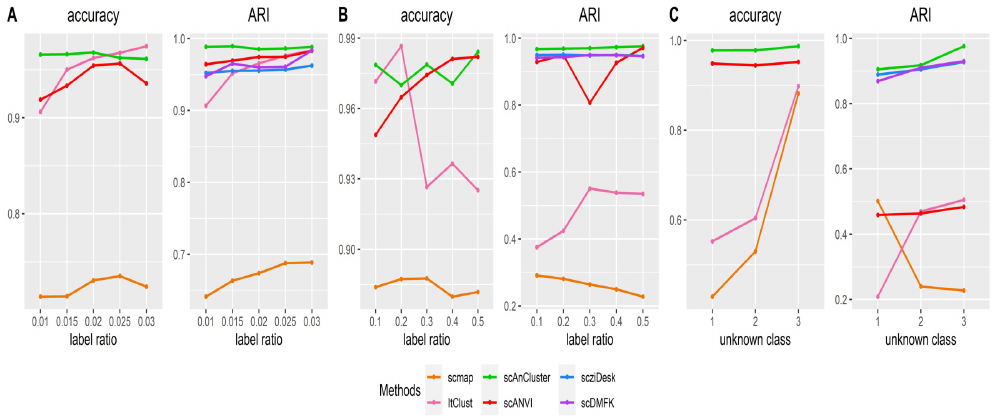
Figure 5. Intra-dataset analysis. ( A – C ) Line plots of ARI and annotation accuracy values for four methods in the “random”, “small(r)” and “large(c)” experiments on the "Campbell" dataset,